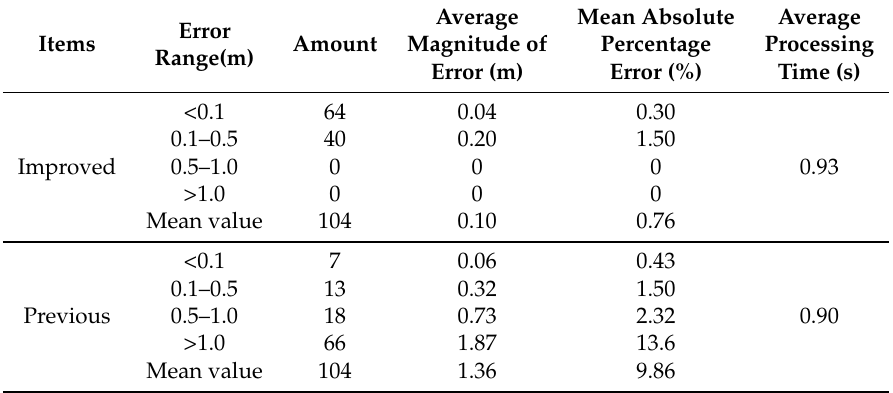
Table 3. Analysis of prediction results of jet trajectory